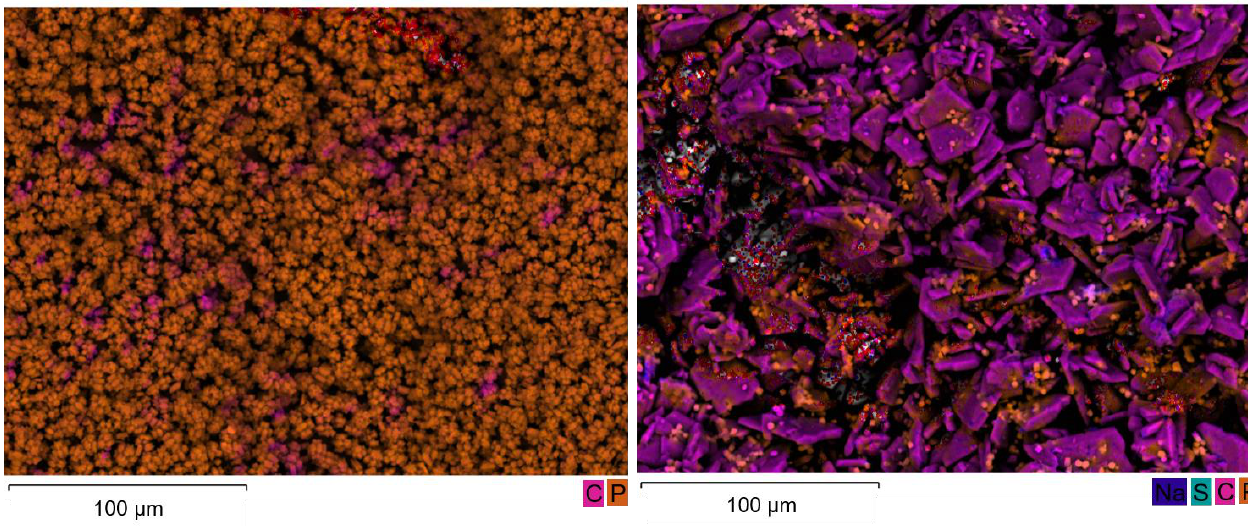
Figure 10. SEM/EDS (Scanning Electron Microscopy/Energy Dispersive X-ray Spectroscopy) analysis of the products from the precipitation processes with phosphatic ( left ) and carbonatic ( right ) precipitants and corresponding element distribution (mapping).